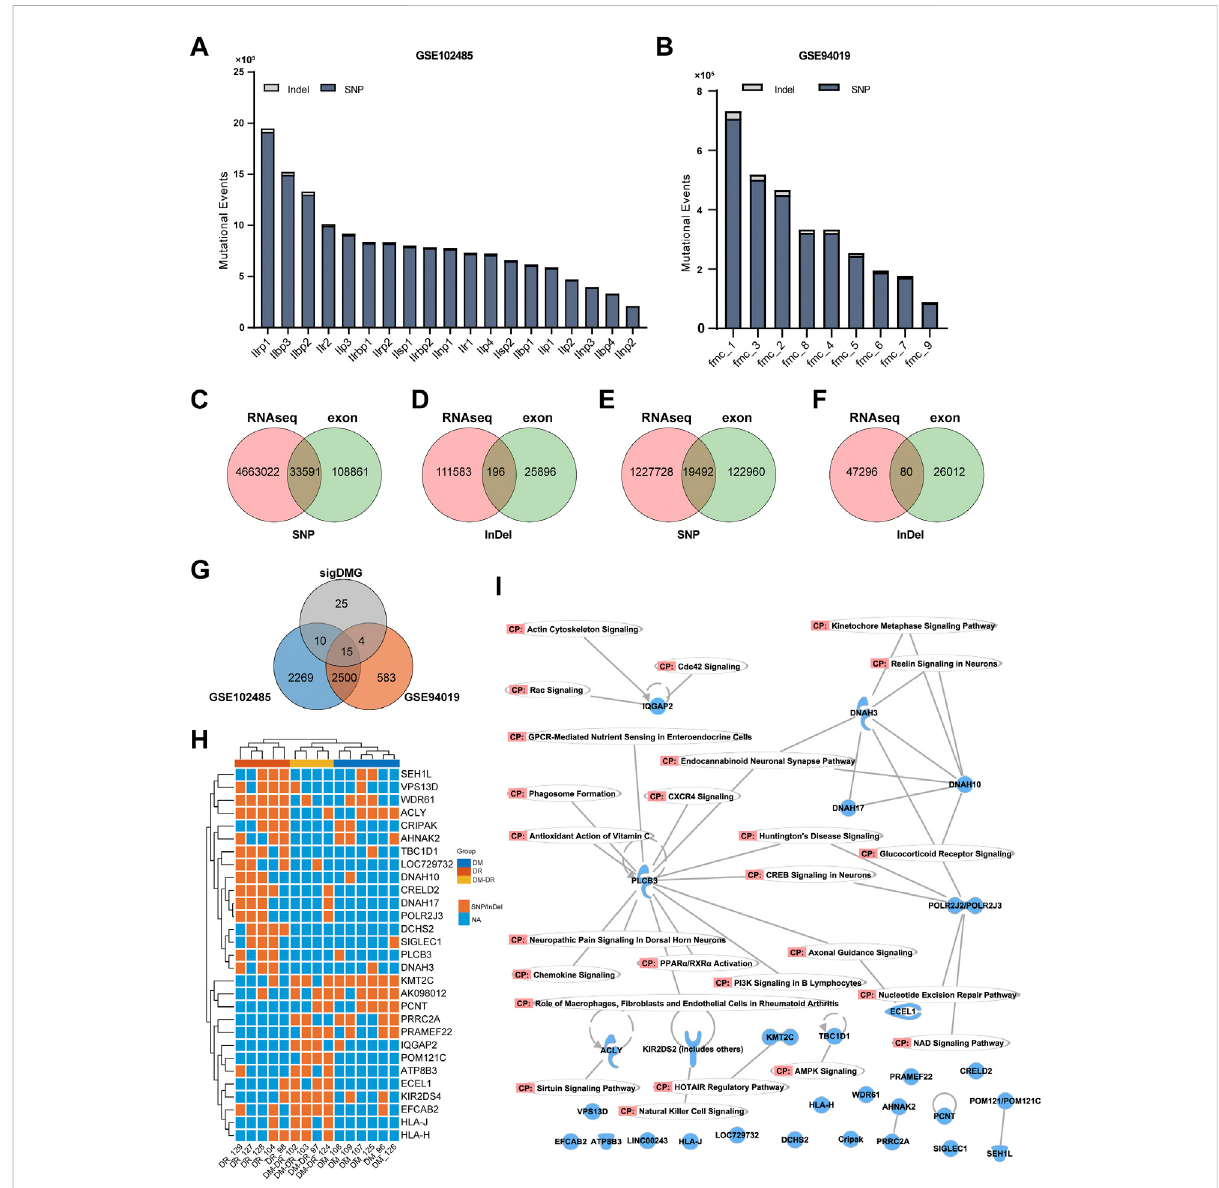
FIGURE 4 Mutant genesveri fi edusing mutation data of eyetissues of patients with diabetic retinopathy (DR). (A,B) overview of thenumbers ofmutational events from the DR-related RNA-seq datasets of GSE102485 (A) and GSE94019 (B) . (C – F) single-nucleotide polymorphism and Indel variants of exome sequencing were validated by RNA-seq data of GSE102485 (C,D) and GSE94019 (E,F) . (G) Venn diagram for the comparison of the 54 signi fi cant DMGs and exonic nonsynonymous mutational genes from RNA-seq datasets. (H) heat map-based hierarchical clustering of the overlapped 29 putatively pathogenic genes in (G) separates these three groups. Under each cluster, thesamples weresub-groupedby their patients of origin. (I) canonical pathway analysis by ingenuity pathway analysis of the overlapped 29